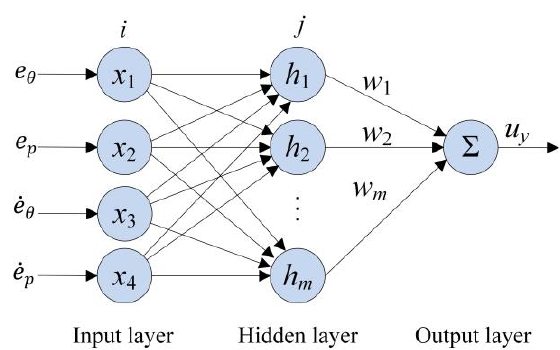
Figure 4. Scheme of the yaw rate controller based on an RBF neural network. As shown in Figure 4, x =